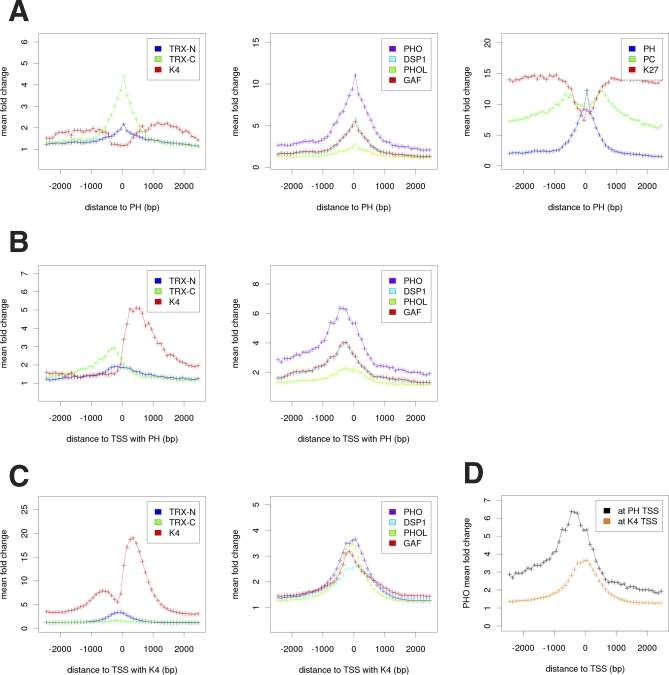
Average Chromatin Profiles at PH Sites and Transcription Start Sites(A) Shown are average fold changes of selected factors around PH local maxima (100-bp intervals in a 2.5-kb flanking region). Note the dip in values of H3K27me3 and PC at PH peaks and the stronger binding of PHO and TRX-C compared to other recruiters and TRX-N, respectively.(B and C) We classified annotated TSS (FlyBase 4.3) according to the existence of a nearby PH site (B) or H3K4me3 local maximum (C). Shown are the average fold changes for selected factors around such TSSs (in intervals of 100 bp [for PH] and 50 bp [for H3K4me3]). Note the strong binding of PHO and TRX-C and the lack of PHOL binding at PH-associated TSS. The shoulder of the H3K4me3 peak in Figure 4C (left panel) likely corresponds to promoter regions of divergently transcribed genes, because we generally do not detect H3K4me3 enrichment 5′ of the TSS of isolated genes.(D) Average fold change of PHO at TSS associated either with PH or H3K4me3.